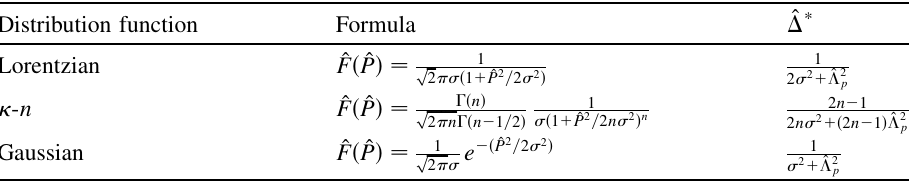
TABLE I. Cutoff frequency of FEL with bell-shaped energy distributions. Distribution function